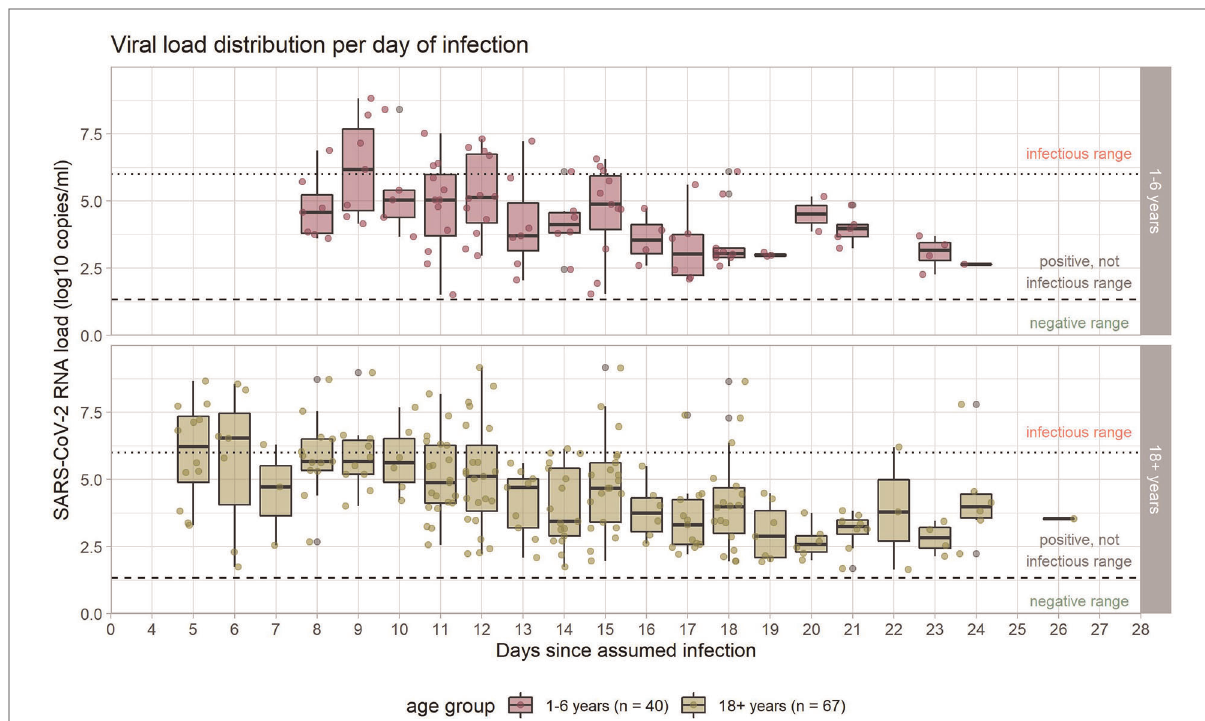
FIGURE 5 Viral load in the course of infection. Medians are calculated for those samples which were available on the given days, and are indicated by midlines; the top and bottom edges of boxes represent the interquartile range (IQR). Whiskers indicate the upper and lower values. Dotted line marks the threshold for infectivity 10^6 RNA copies/ml ( ≙ CT 24.7 in our laboratory); dashed line marks the threshold for positivity with values >=10^1 RNA copies/ml ( ≙ CT 40 in our laboratory) considered as positive. Analysis restricted to samples considered positive (104 samples in 40 children, 214 samples in 67 adults) with increasingly fewer samples in the progression of the course of